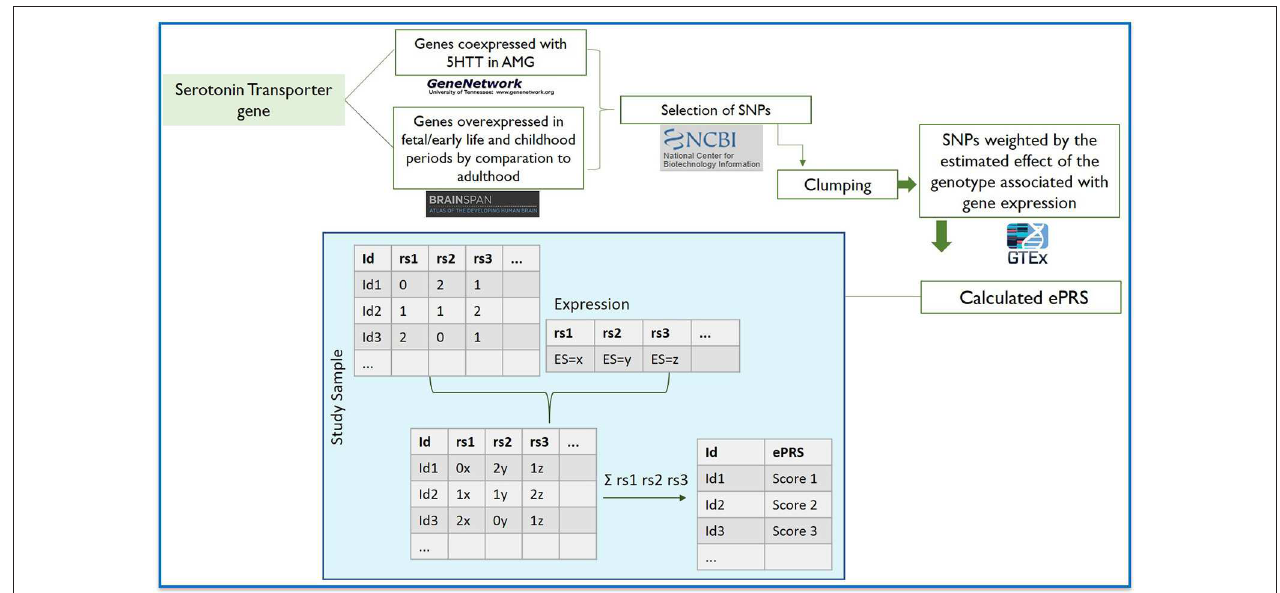
FIGURE 1 | Flowchart depicting the steps involved in creating the expression-based polygenic risk score based on genes co-expressed with serotonin transporter gene in amygdala using gene co-expression databases: GeneNetwork was used to generate a co-expression matrix with 5-HTT gene in the amygdala in mice (absolute value of the co-expression correlation r ≥ 0.5); BrainSpan was then used to identify consensus human transcripts from this list; BrainSpan was also used for selecting genes differentially expressed at ≥ 1.5-fold during child and fetal development as compared to adulthood within the same brain areas. Based on their functional annotation in the National Center for Biotechnology Information, U.S. National Library of Medicine, we gathered all the existing SNPs from these genes and subjected this list of SNPs to linkage disequilibrium clumping. We used a count function of the number of alleles at a given SNP (rs1, rs2…) weighted by the estimated effect of the genotype associated with gene expression. The sum of these values from the total number of SNPs provides the amygdala 5-HTT ePRS